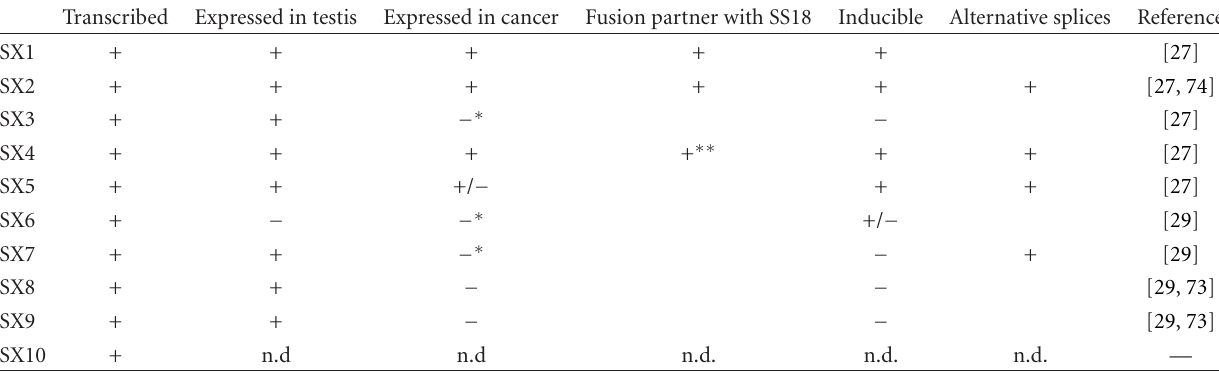
Table 1: SSX family members: expression, fusion constructs, inducibility, and isoforms. The mRNA expression patterns of the ten known SSX family members are shown for testis and tumor tissues in columns 2, 3, and 4, while SSX family members known to be involved in the SS18-SSX fusion event are shown in column 5. SSX members shown to be inducible with epigenetic modifying agents or known to have alternative splice isoforms are shown in columns 6 and 7, respectively. References are given in column 8.